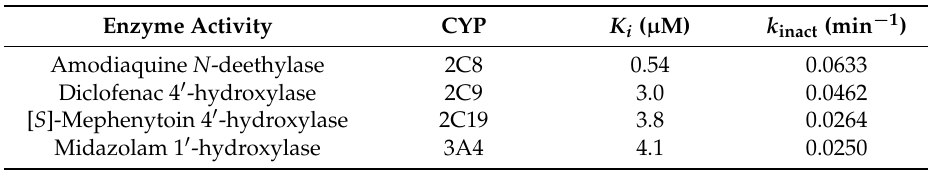
Table 1. K i and k inact values for the time-dependent inhibition of EAM-2201 on four cytochrome P450 (CYP) metabolic activities in ultrapooled human liver